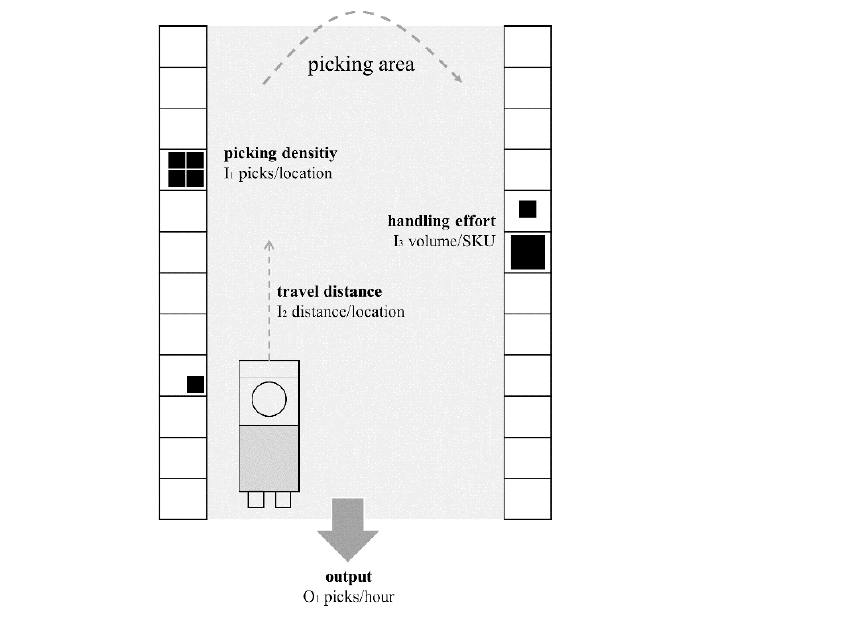
Figure 3. The linkage between the order picking process and input/output factors.